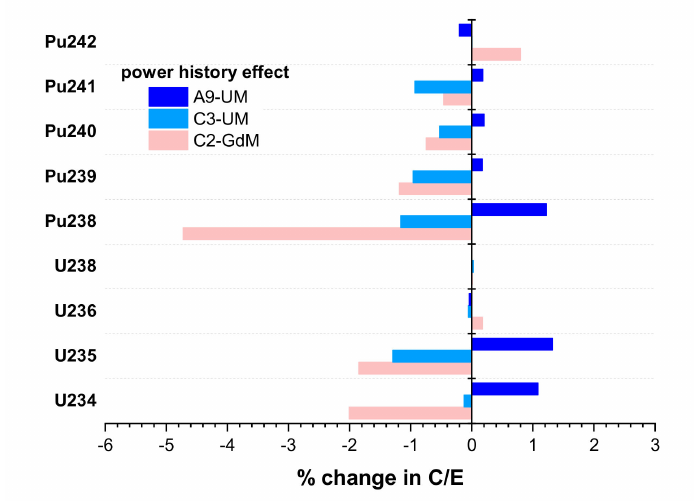
Figure 3. Change in U and Pu isotope C/E ratios with sample power approach (based on nodal average power vs. fuel rod power) for samples from assembly